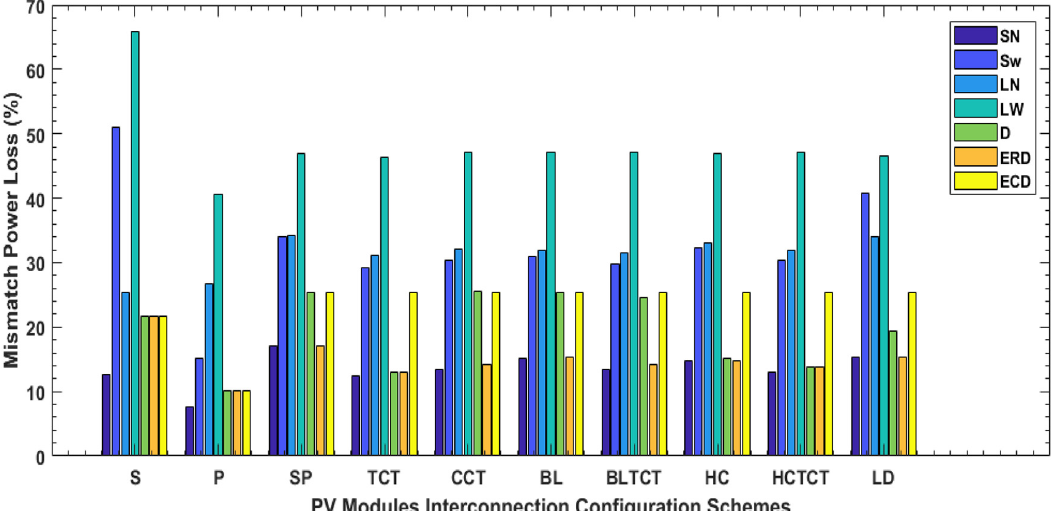
Fig. 12. Comparative illustration of mismatch power loss of PV modules interconnection con fi guration schemes under partial shading